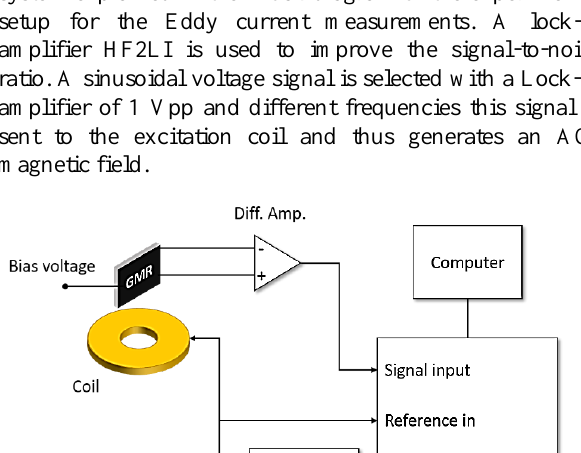
FIGURE 4. Output voltage of the magnetic sensor changed with the external magnetic field in different temperatures, 5v supply. [12]